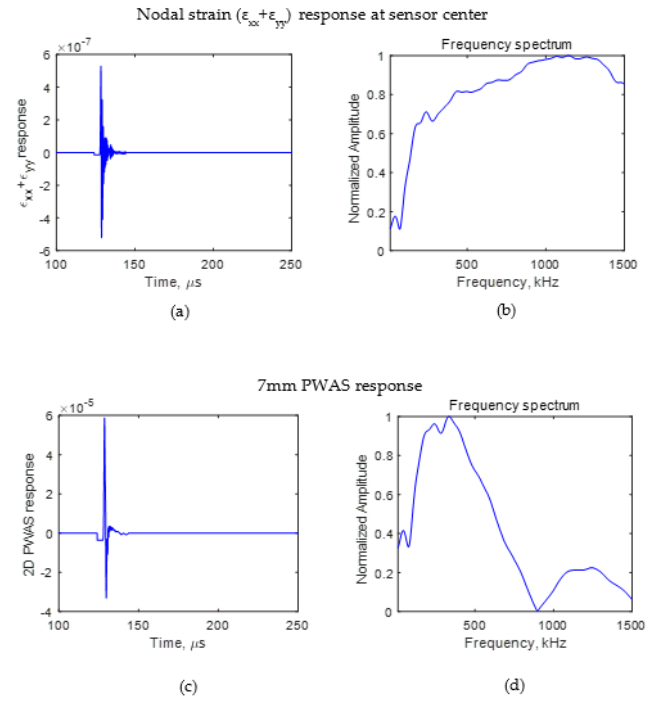
Figure 5. FEM simulation AE signal sensed at 25 mm in the case of no-crack. ( a ) Nodal in-plane strain response of AE signal; ( b ) frequency spectrum of nodal in-plane strain response of AE signal; ( c ) PWAS response of AE signal; ( d ) frequency spectrum of PWAS response of AE signal.